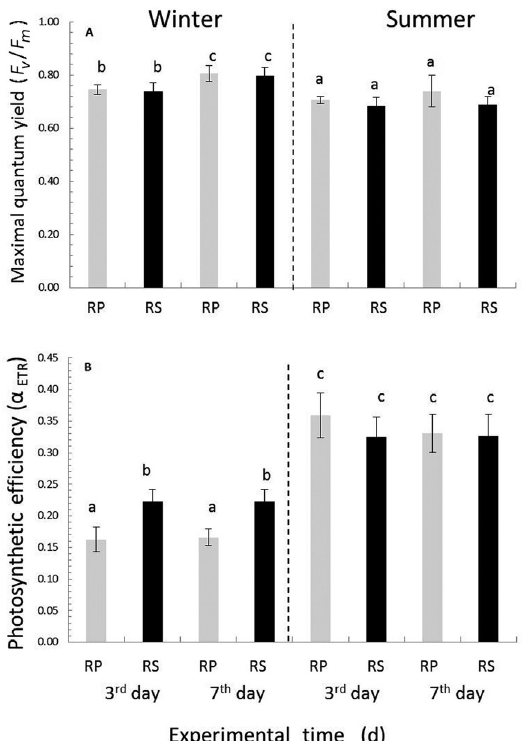
Fig. 4. – Maximum electron transport rate (ETR ) (A) expressed as max μmol electrons m –2 s –1 and maximum non-photochemical quenching (NPQ ) (B) in C. tamariscifolia during the experimental period max (3 rd and 7 th days) in algae incubated in 1.5-L cylindrical vessels. The algae were collected in winter (February) and summer (July) from rockpools (RP) and rocky shores (RS). Data are expressed as mean±standard deviation of n=6 and lower-case letters denote significant differences after SNK test.